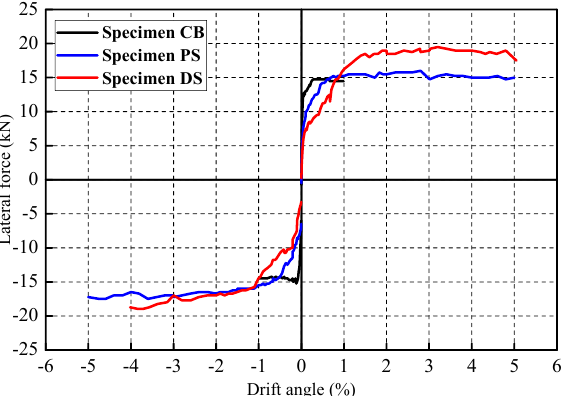
Figure 12. Equivalent viscous damping ratios.